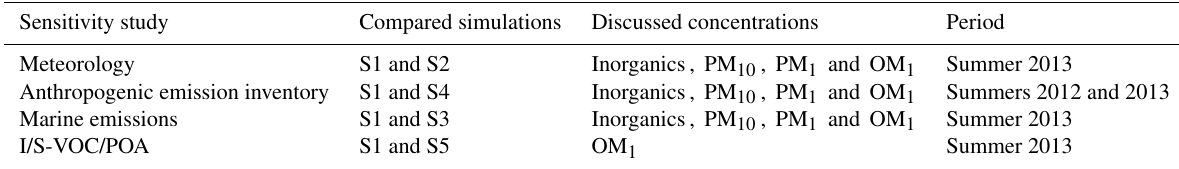
Table 2. Summary of the different sensitivity simulations for the ground-based